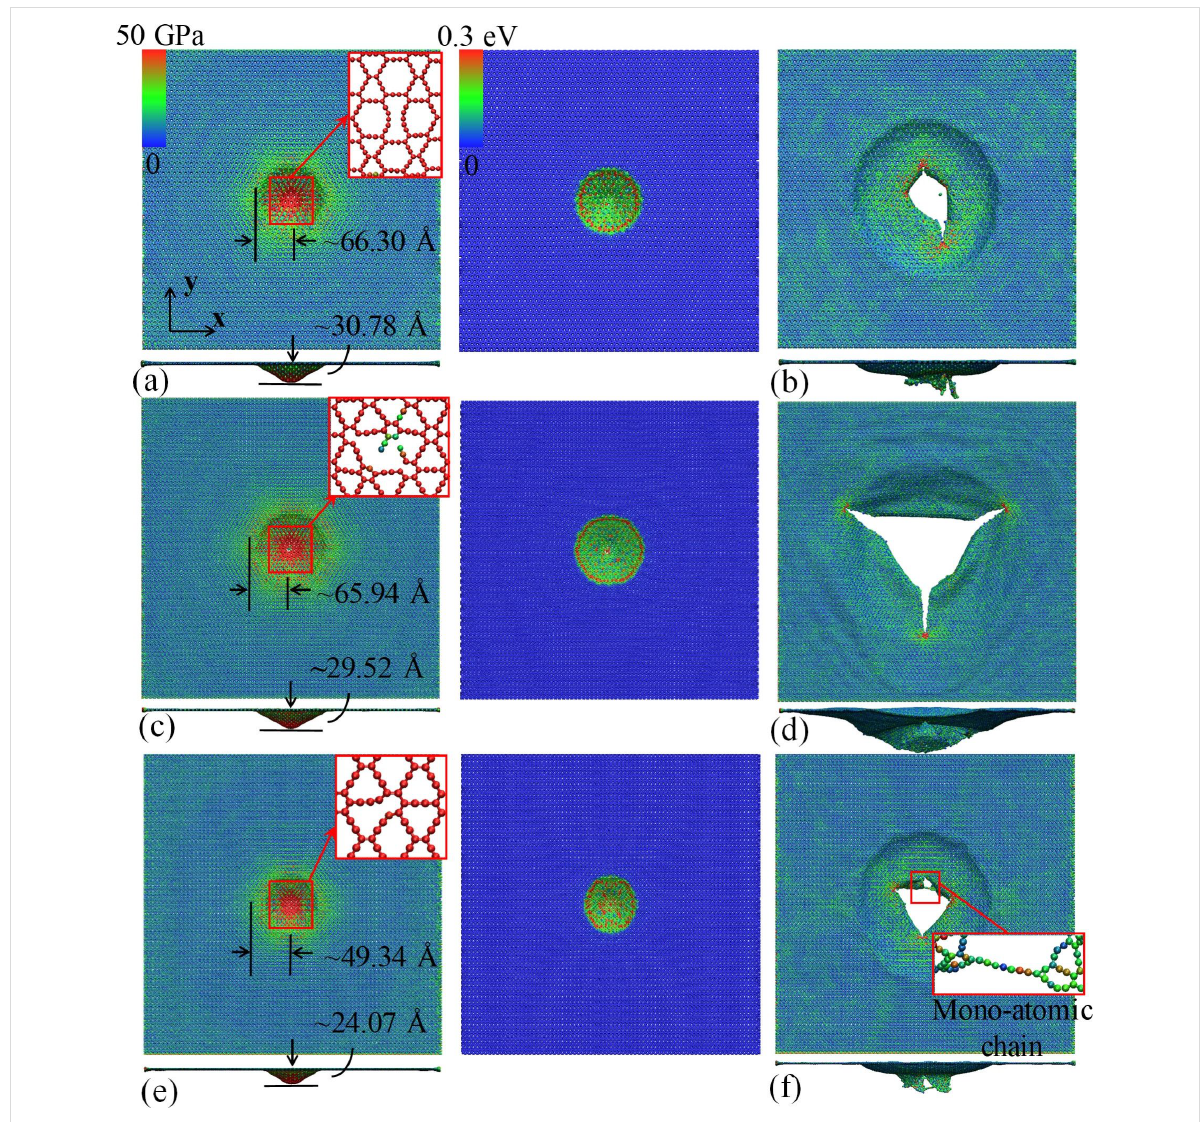
Figure 4: Impact deformation of different GYs under an impact velocity of 2 km/s. (a, b) Atomic configurations of β -GY: (a) von Mises atomic stress distribution pattern at a simulation time of 2.0 ps (left panel), and the corresponding kinetic energy distribution pattern (right panel); the insert in the left panel shows the formation of initial cracks at the impact area; and (b) final atomic configuration after 4.9 ps. (c, d) Atomic configurations of γ -GY: (c) von Mises atomic stress distribution pattern at a simulation time of 20 ps (left panel), and the corresponding kinetic energy distribution pattern (right panel); the insert in the left panel shows the formation of initial cracks at the impact area; and (d) final atomic configuration after 9.7 ps. (e, f) Atomic configurations of 6612-GY: (e) von Mises atomic stress distribution pattern at a simulation time of 1.6 ps (left panel), and the correspond- ing kinetic energy distribution pattern (right panel); the insert in the left panel shows the formation of initial cracks at the impact area; and (f) final atomic configuration after 4.5